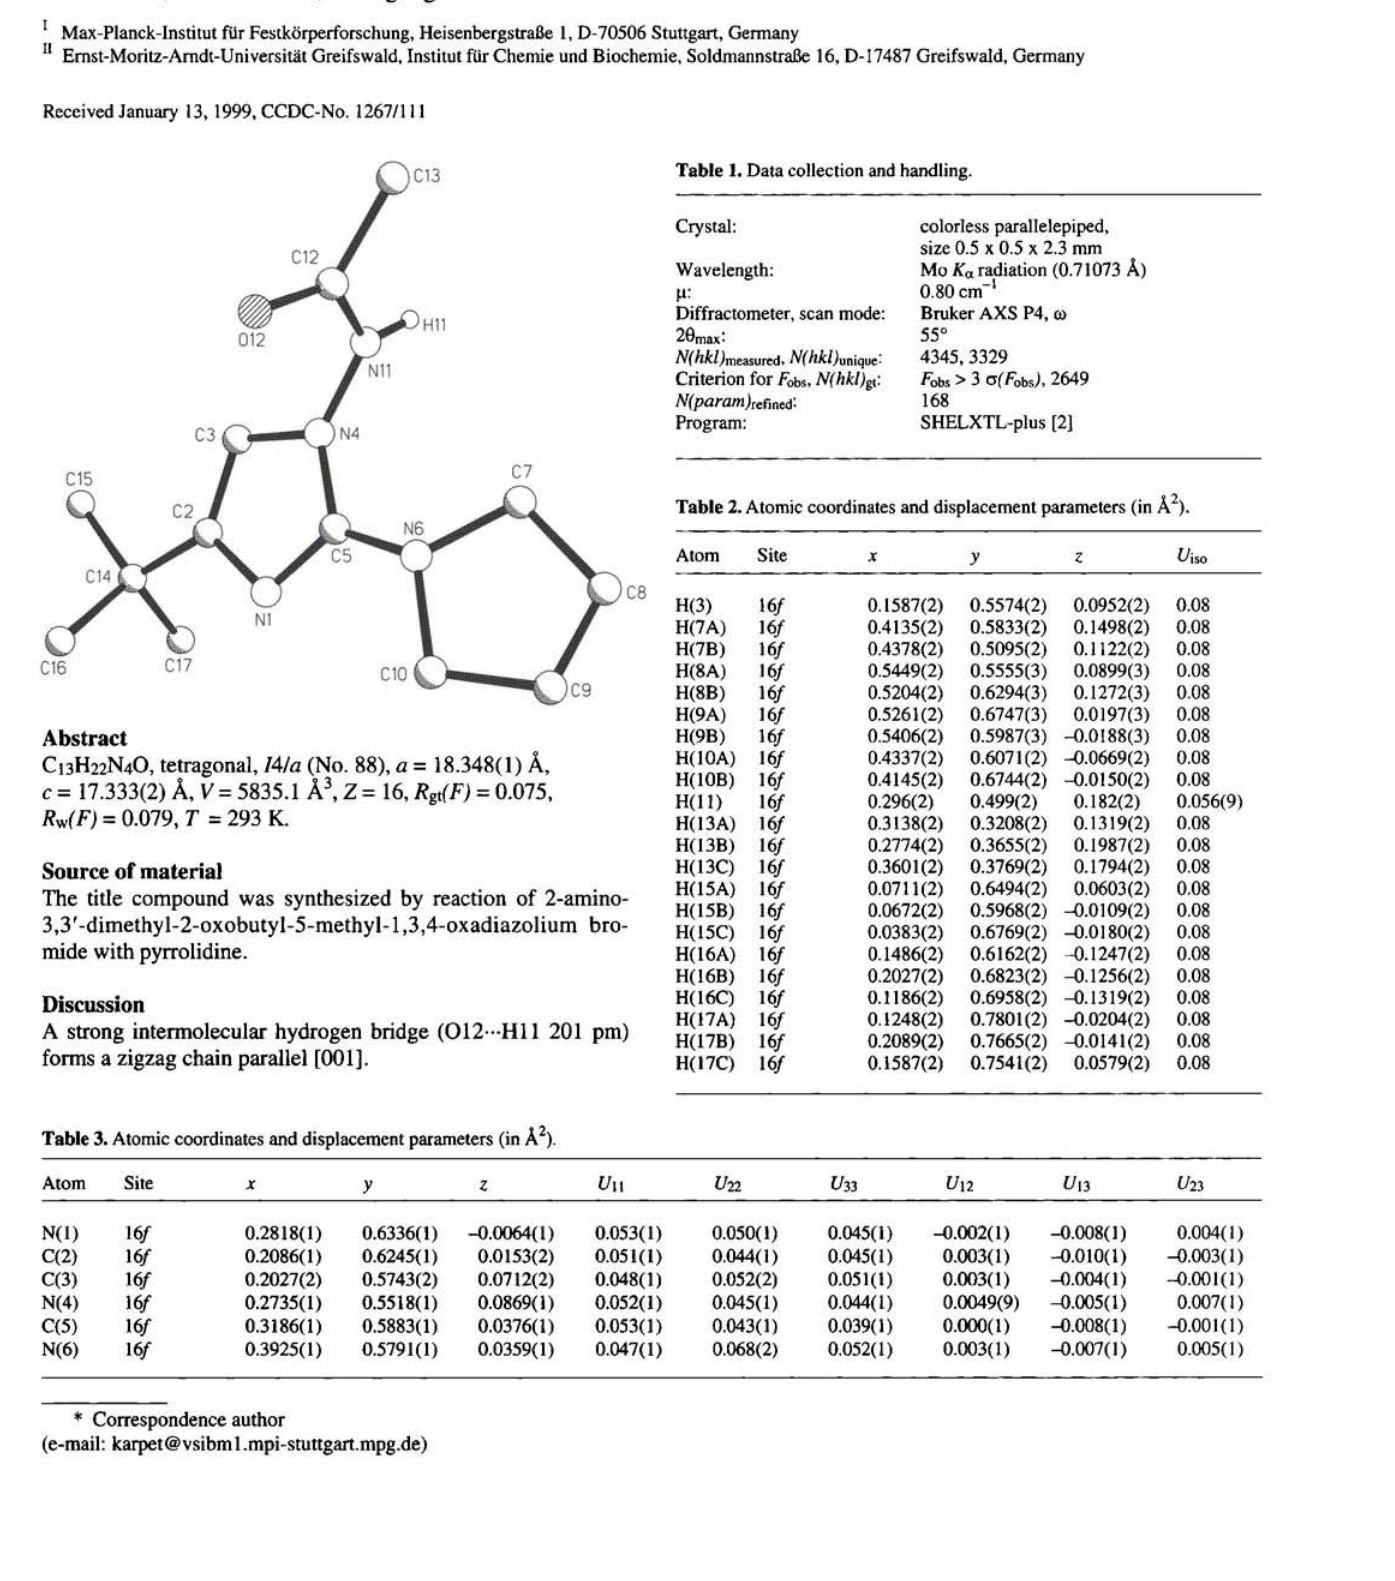
Table 1. Data collection and handling.